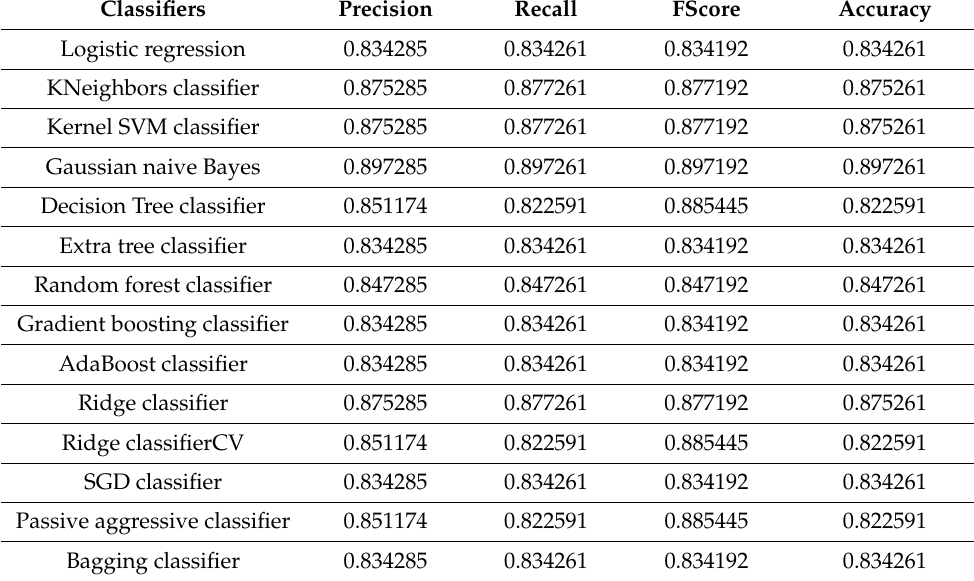
Table 22. Extra trees classifier metrics after feature scaling.